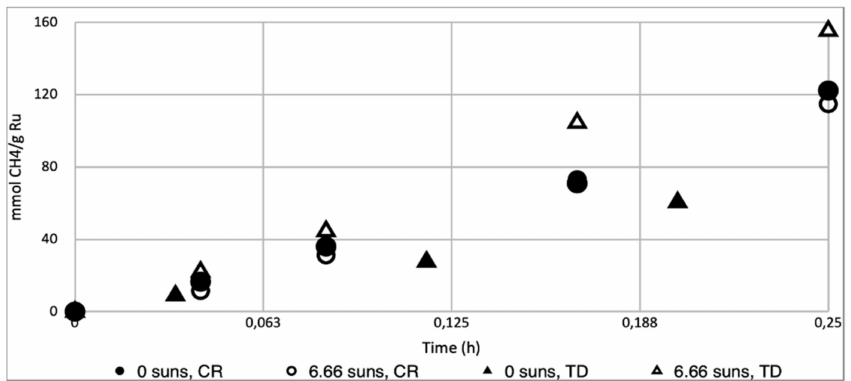
Figure 3. Conversion-time profile for the Sabatier reaction carried out in dark (0 suns) and light conditions (6.66 suns) with Ru/Al 2 O 3 catalysts prepared using Ru 3 (CO) 12 (TD, 3.6% w / w Ru) [33] and RuCl 3 (CR, 3.89% w / w ). Reaction conditions for all experiments: reaction mixture of H 2 /CO 2 /N 2 (4.5:1:1) at 3.5 ± 0.2 bar pressure, 200 mg of Ru/Al 2 O 3 or Ru/SiO 2 catalyst, catalyst bed temperature of approximately 220 ◦ C.